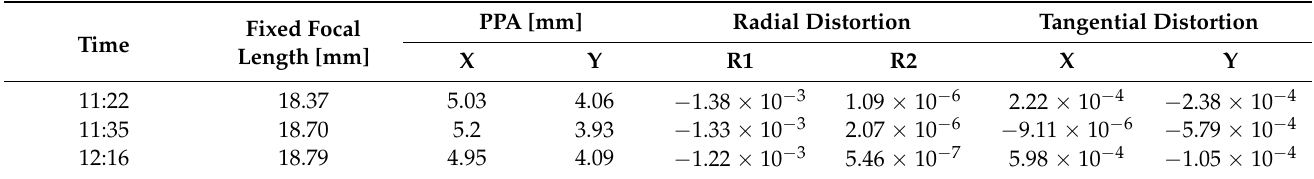
Table A4. Results of geometric calibration for three measurement series for raw images.